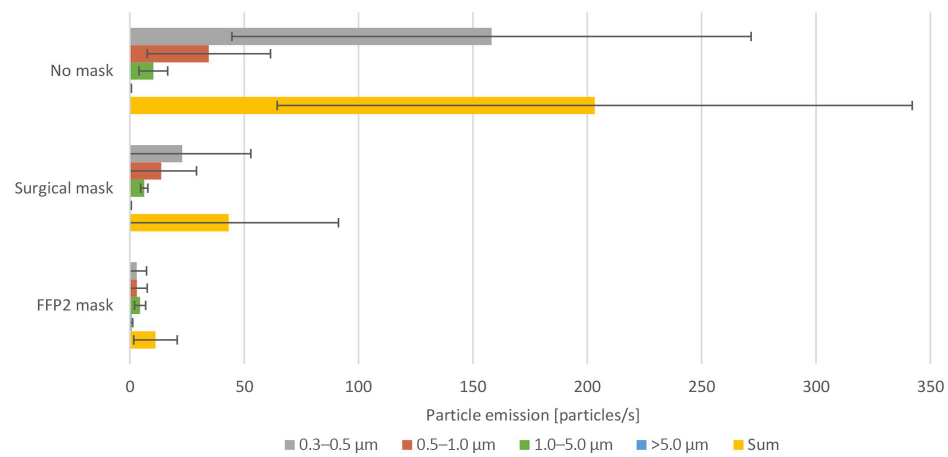
Figure A1. The mean particle emission rate [particles/s] and the mean size distributions of the emit- ted particles from all test subjects when wearing no mask, surgical mask, and FFP2 mask.